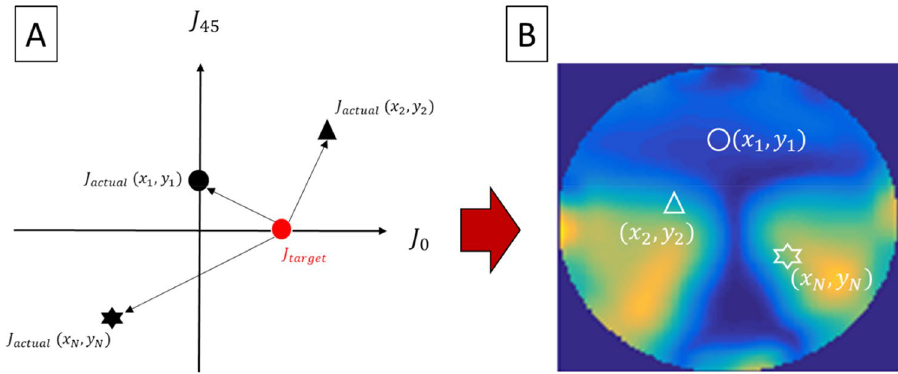
Figure 2. Derivation of cylindrical errors at different locations (cid:31) x , y (cid:30) on the lens surface. ( A ) Actual cylindrical refractions J actual at three separate locations (black symbols) on the lens surface are represented by their respective J 0 and J 45 coordinates. Cylindrical error at each position is quantified by subtracting the target J target (red circle) from the actual J actual (black symbols), as indicated by the arrowhead. ( B ) An error map is constructed by computing the cylindrical error for each location on the lens surface. Cylindrical errors computed for the three locations in ( A ) are represented by open symbols. The color gradient highlights the levels of mismatch between actual and target cylinder power, which progressively increases from blue to red colors.